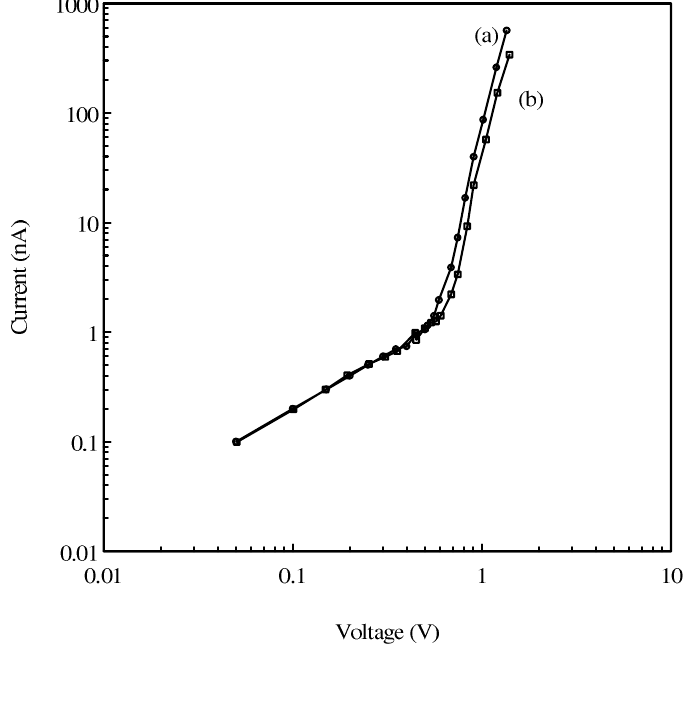
Figure 2. Current-voltage characteristics of a fresh TiO (a) nitrogen, (b) 150 ppm benzene at room